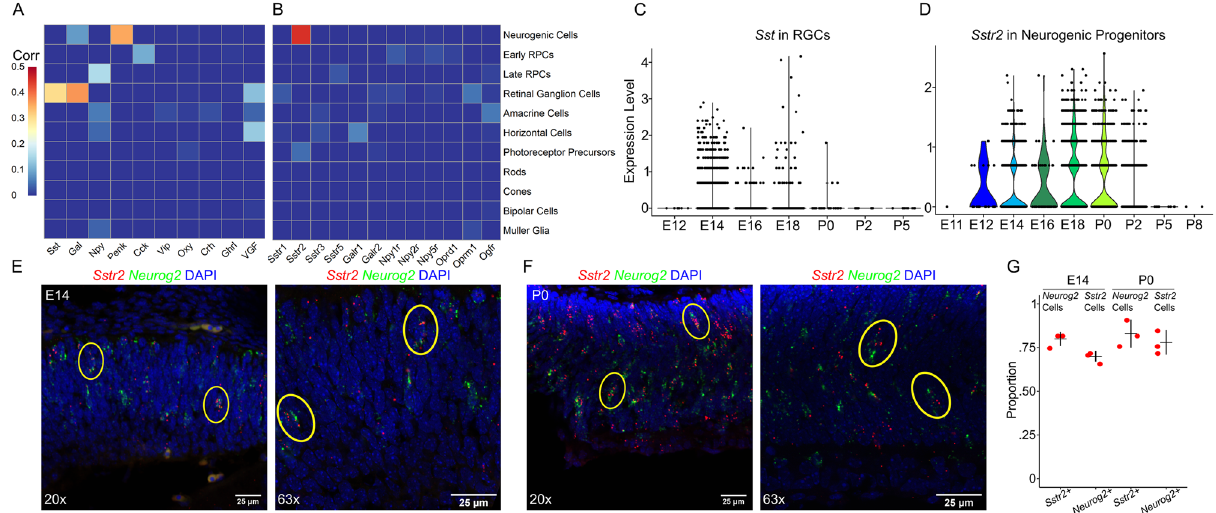
Figure 1. Cell-specific expression of neuropeptides and neuropeptide receptors in developing mouse retina. ( A ) Heatmap of the correlation of expression of a neuropeptide with a given cell type across the full course of mouse retinal neurogenesis (E11-P14) 31 . ( B ) Correlation of expression of a neuropeptide receptor with a given cell type across the full course of mouse retinal neurogenesis. Sstr4 , Galr3 , and Npy4r were not expressed at detectable levels in the dataset. ( C ) Violin plot of Sst expression in retinal ganglion cells across mouse development. Each point represents a single cell. Expression determined by the SCT method in Seurat. ( D ) Violin plot of Sstr2 expression in neurogenic progenitor cells across mouse development. ( E ) E14 and ( F ) P0 mouse retina hybridized with RNAscope smFISH probes for Sstr2 (red) and Neurog2 (green) and counterstained with DAPI (blue). Example cells expressing both Sstr2 and Neurog2 circled in yellow. 20 × Resolution on the left and 63 × resolution on the right. Scale bars represent 25 μm. ( G ) Dot plot quantifying overlap of cellular expression for Sstr2 and Neurog2 at E14 and P0. Black crosses represent average and standard deviation. N = 3 retinas for each age. Correlation calculated using base R function